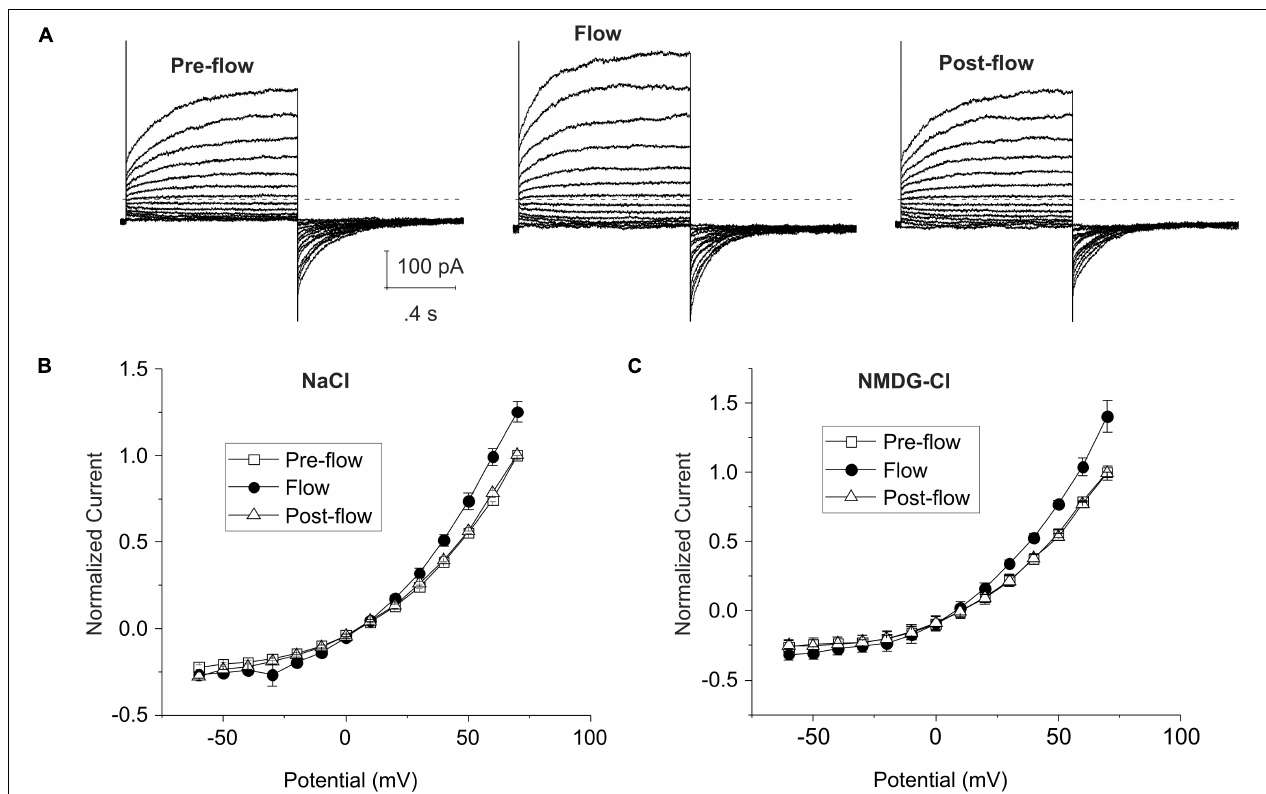
FIGURE 1 | Shear stress induces changes in whole cell chloride current in differentiating lens cells. (A) Representative families of current traces recorded before, during and after fluid flow. Bath solution contained NaCl solution; patch pipette contained CsCl internal solution to which calcium was added to give a final free calcium concentration of ∼ 300 nM. The voltage clamp protocol consisted of a series of sequential steps from a holding potential of –60 mV to potentials ranging between –60 and 80 mV in 10 mV increments. The dashed line represents zero current level. (B) Effect of flow on the normalized steady-state I–V curve in standard NaCl solution ( n = 4). The steady-state current measured at the end of the 20-s pulse was normalized to the steady-state current at +70 mV pre-flow and plotted as a function of voltage before (open squares), during flow (filled circles) and after cessation of flow (open triangles). (C) Effect of flow on the normalized steady-state I–V curve in NMDG-Cl solution ( n = 6). Pipette solution consisted of NMDG-Cl containing 300 nM [Ca 2 + ] i . The steady-state current measured at the end of the 20-s pulse was normalized to the steady-state current at +70 mV pre-flow and plotted as a function of voltage before (open squares), during flow (filled circles) and after cessation of flow (open